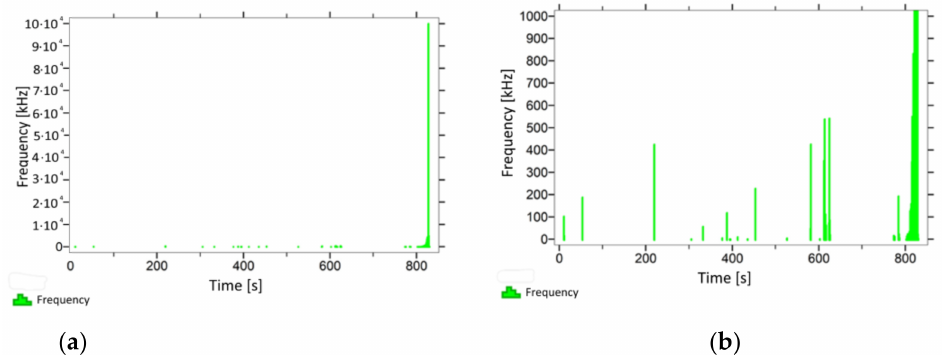
Figure 7. Graph of frequency distribution during the test for a representative sample from series P 6 : ( a ) considering the entire occurring frequency range and ( b ) with details about the frequency range before the moment of breakage.